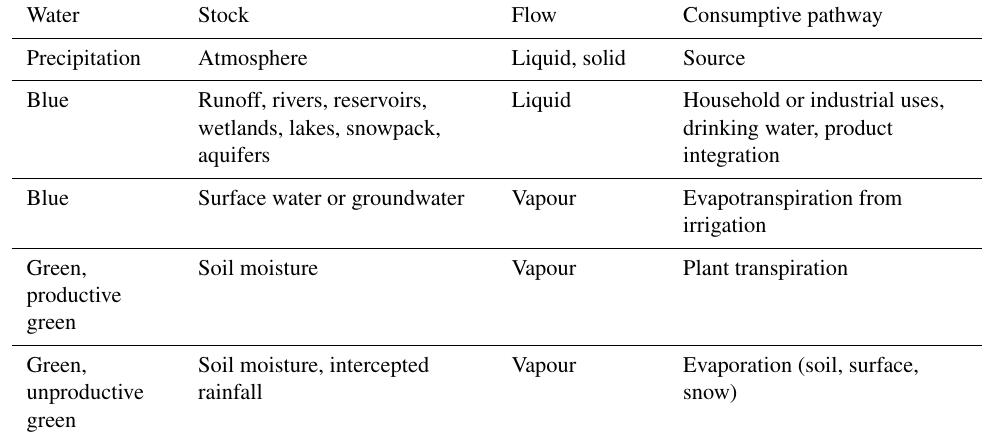
Table 1. Representation of water resource terminology in the green- and blue- water ecohydrological approach (Falkenmark and Rockström, 2004, 2006). Water Stock Flow Consumptive pathway Precipitation Atmosphere Liquid, solid Source Liquid Household or industrial uses, Blue Runoff, rivers, reservoirs, drinking water, product wetlands, lakes, snowpack, integration aquifers Blue Surface water or groundwater Vapour Evapotranspiration from irrigation Soil moisture Vapour Plant transpiration Green, productive green Soil moisture, intercepted Vapour Evaporation (soil, surface, Green, rainfall unproductive green